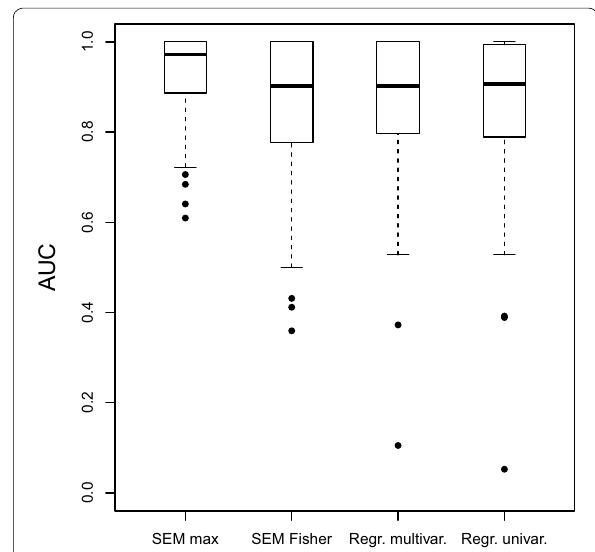
Fig. 3 Simulation AUC for SNP selection. Shown are the results for two methods of p value integration for our model (SEM max and SEM Fisher), for multivariate logistic regression and univariate logistic regression. A high AUC means that the method correctly ranks the importance of the SNPs for the phenotype (disease